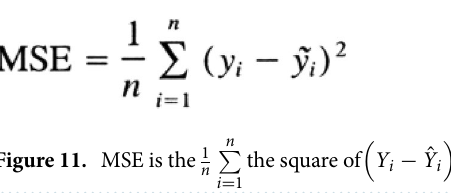
Figure 11. MSE is the